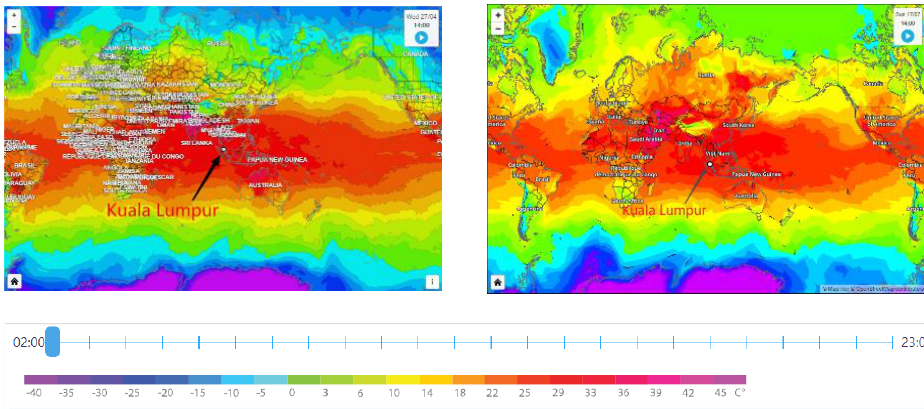
Figure 1. Maps of global temperature zone, (source: https://www.foreca.com/, accessed on 15 August 2022).